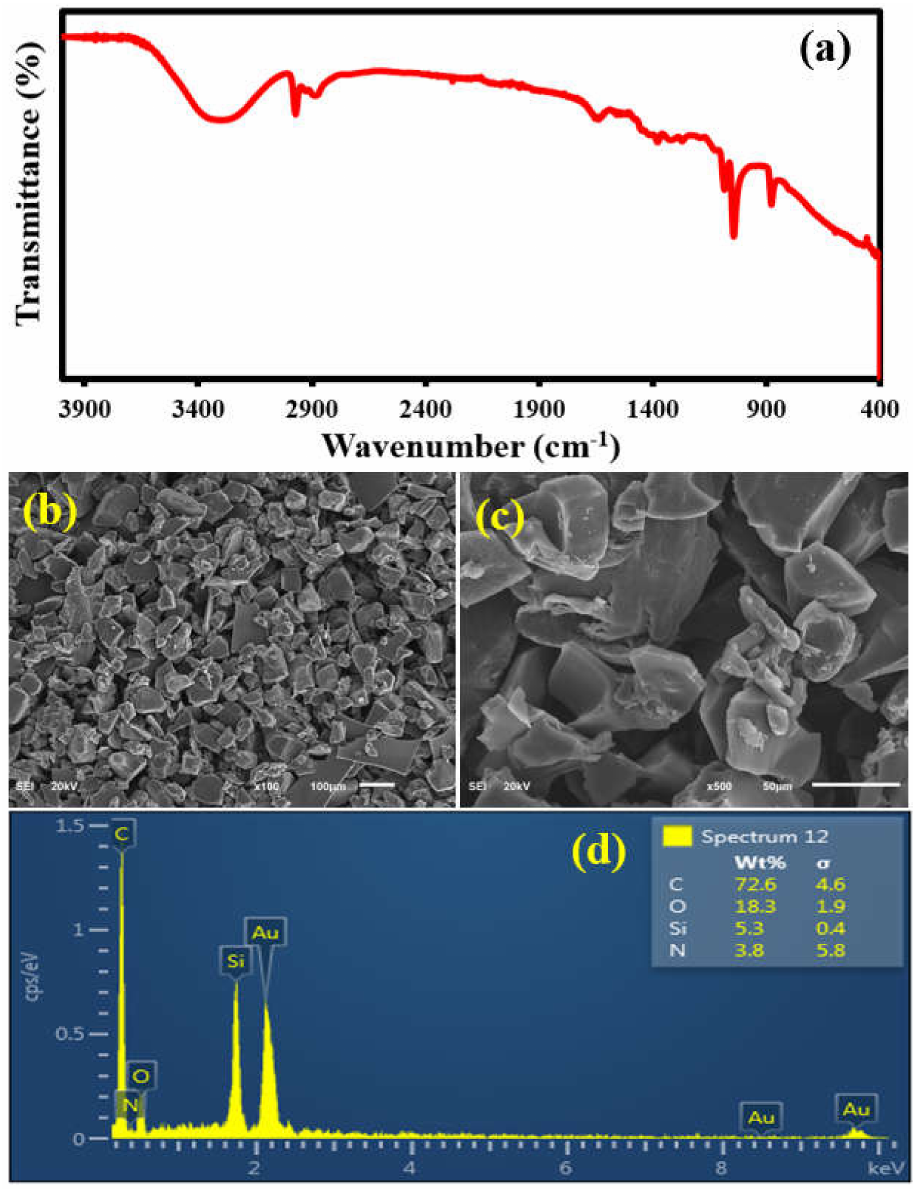
Figure 3. ( a ) The FTIR analysis, ( b , c ) the FESEM and ( d ) EDX analysis of